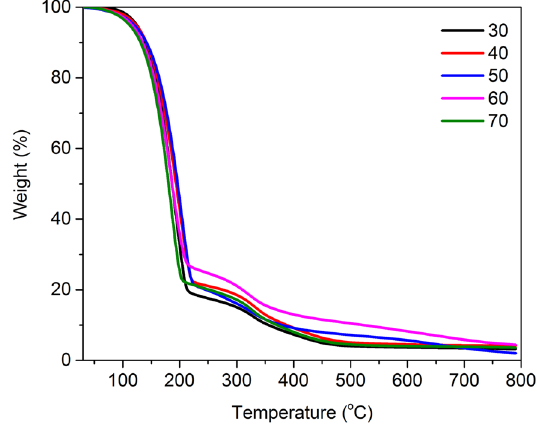
Figure 6: Particle size distribution curves of BSA/AM microcapsules under di ff erent ultrasound